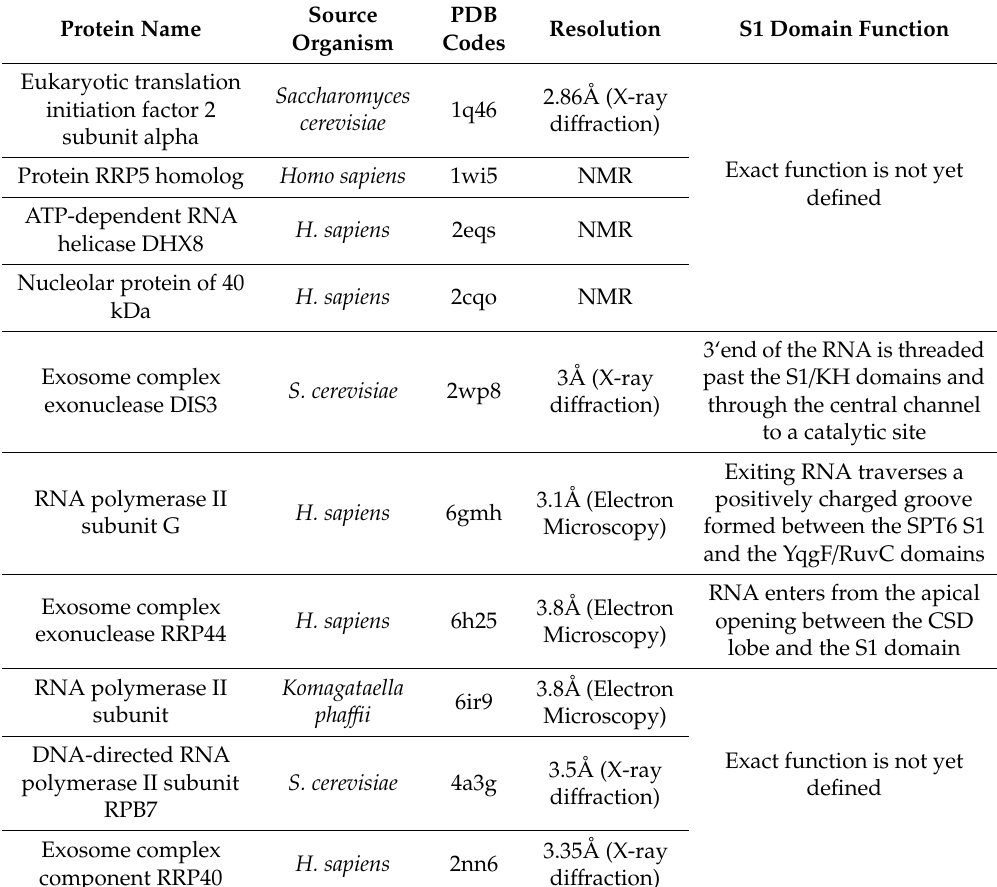
Table 2. Eukaryotic proteins containing the S1